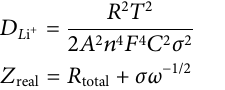
Frontiers in Chemistry |